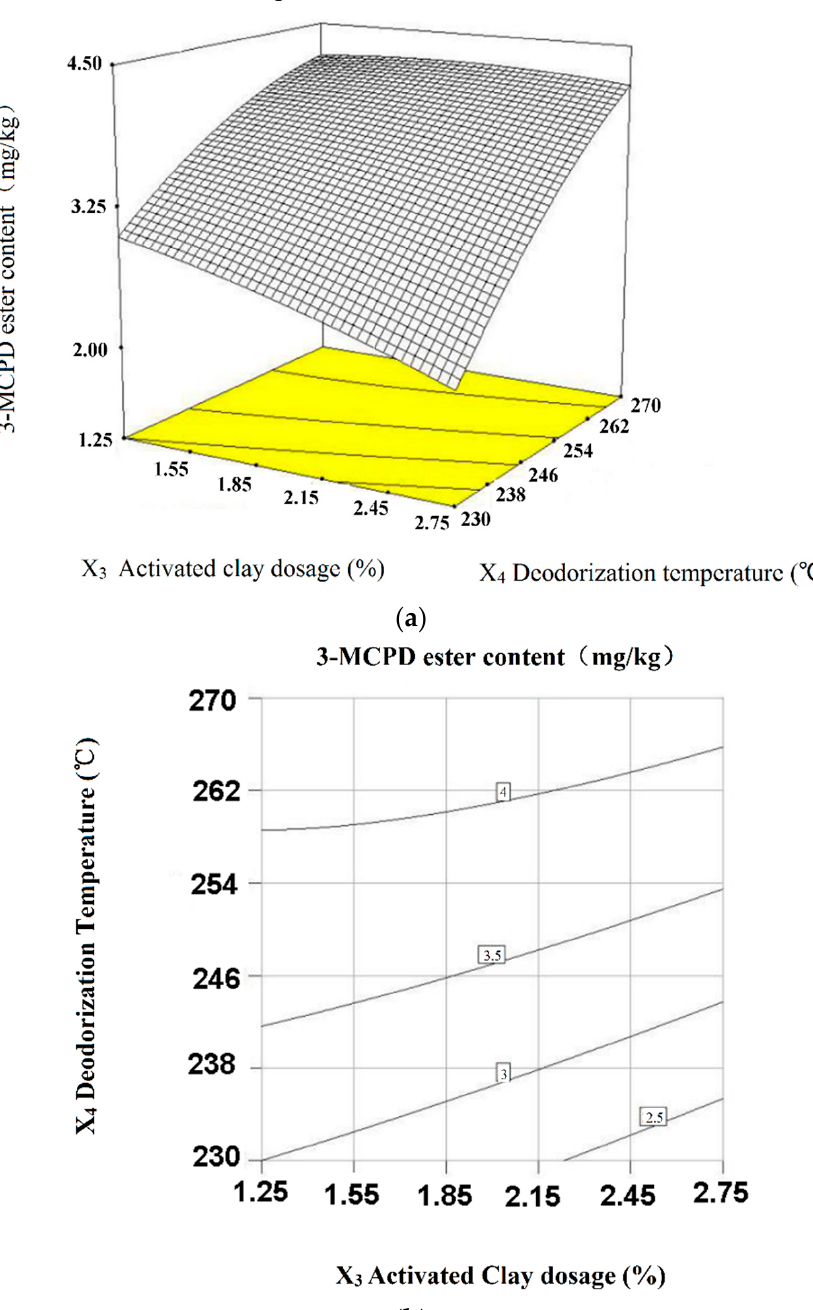
Figure 3. Response surface curves ( a ) and contours ( b ) of activated clay and deodorization temperature towards 3-MCPD ester (interactions of X 3 X 4 , p < 0.01).